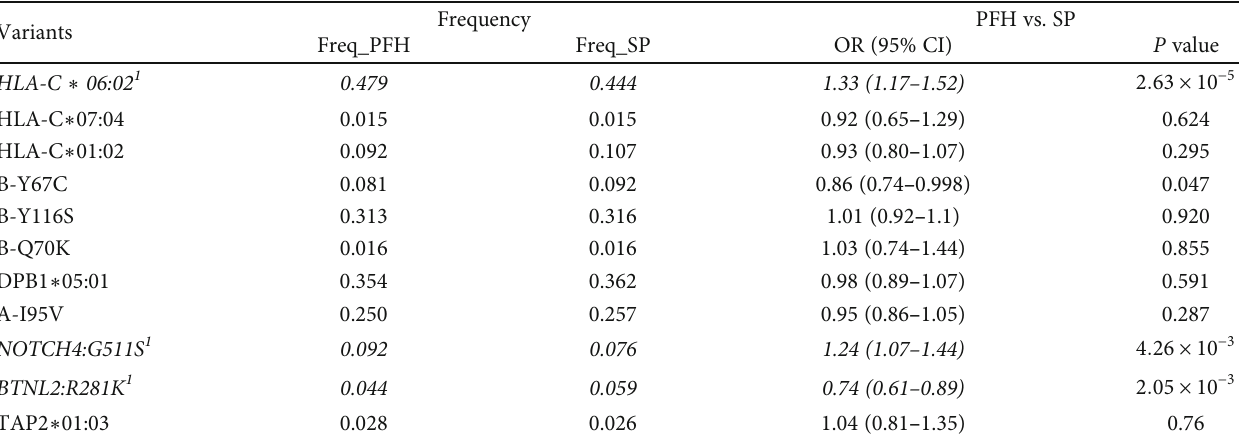
Table 4: Association of human leukocyte antigen (HLA) with a family history of